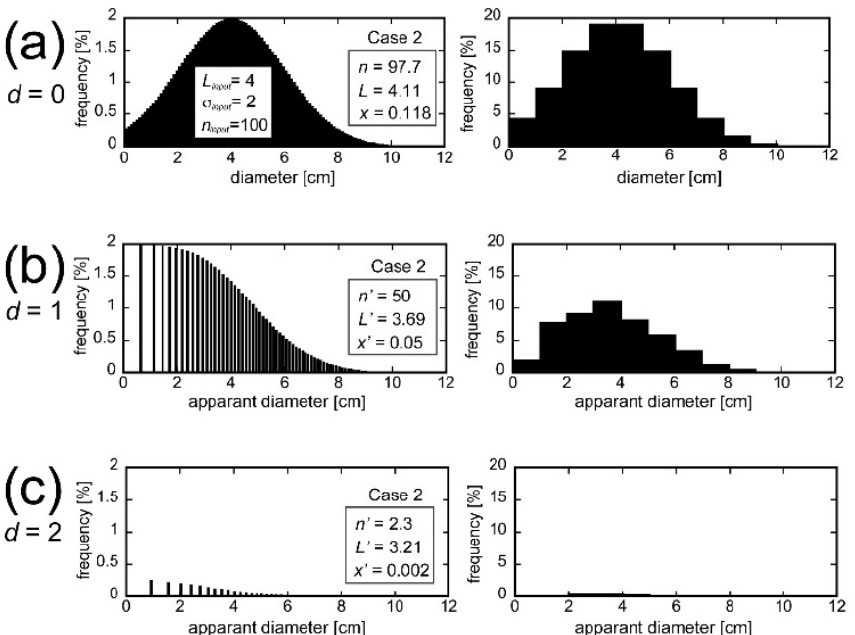
Figure 8. Histograms showing calculation results for various values of d in Case 2. ( a ) d = 0; ( b ) d = 1; ( c ) d = 2. See text for details.